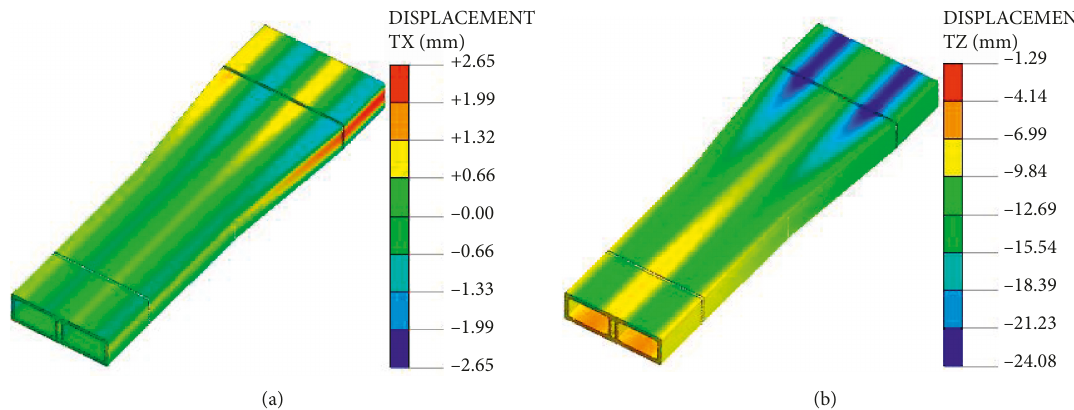
Figure 6: The displacement nephogram under working condition 1: (a) horizontal displacement; (b) vertical displacement.